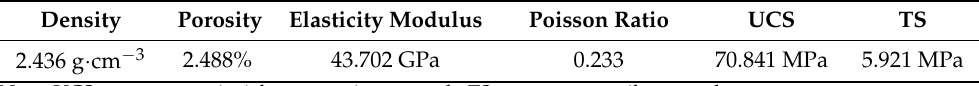
Table 1. Some physical and mechanical properties of the investigated sandstone. Density Porosity Elasticity Modulus Poisson Ratio